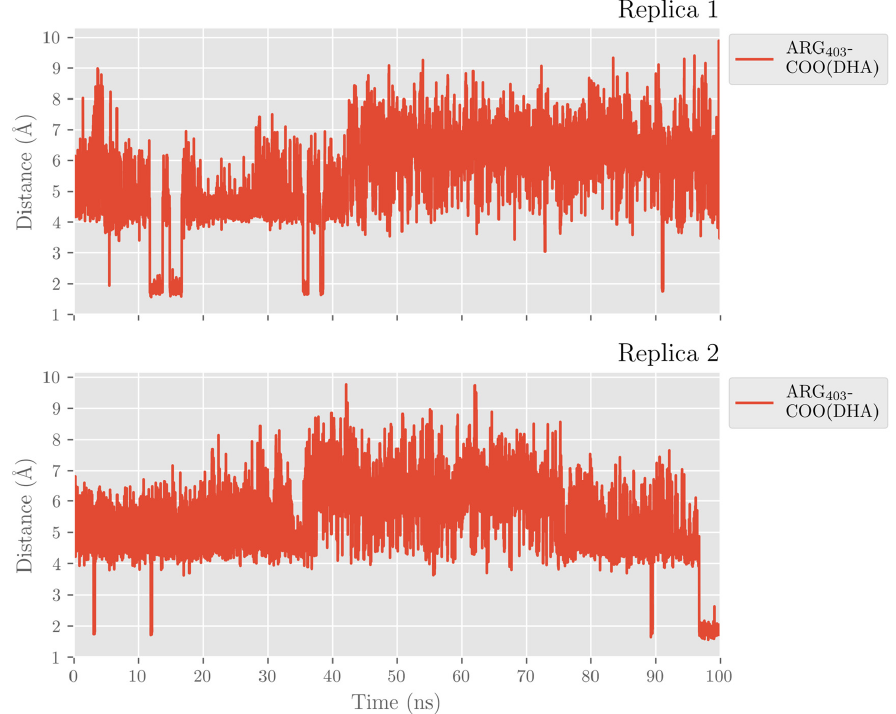
Int. J. Mol. Sci. 2023 , 24 , x FOR PEER REVIEW Figure 17. Distances of a carboxylate’s oxygen atom of DHA to the closest hydrogen atom in Arg403 versus time for the MD replica 1 and replica 2 in pigALOX15-mini-LOX. This interaction is lost because a displacement of the α 2-helix in pigALOX15-mini- LOX moves away from the Glu176...Arg403 pair (Glu175…Arg402 in hALOX12) from the cavity entrance. Moreover, pigALOX15-mini-LOX has a Gly in position 407 instead of the Gln406 of hALOX12, which does not interact with Arg403 and cannot maintain this argi- nine close to the DHA carboxylate. Therefore, in its location in pigALOX15-mini-LOX, the carboxylate head of DHA only interacts with some water molecules. In addition, DHA also establishes π – π interactions between its double bonds and aromatic residues of the active site that stabilize the substrate binding mode. The stacking interactions between Phe175 and Δ 4 and Δ 7 are plo tt ed in Figure 18. Along the MD replicas, Phe175 exchanges its interaction between those two double bonds, except during the fi rst 30 ns of replica 2 when the stacking is present with both double bonds at the same time. The rest of the π – π interactions presented in Figure S5 are weaker in pigALOX15-mini-LOX than in hA- LOX12.